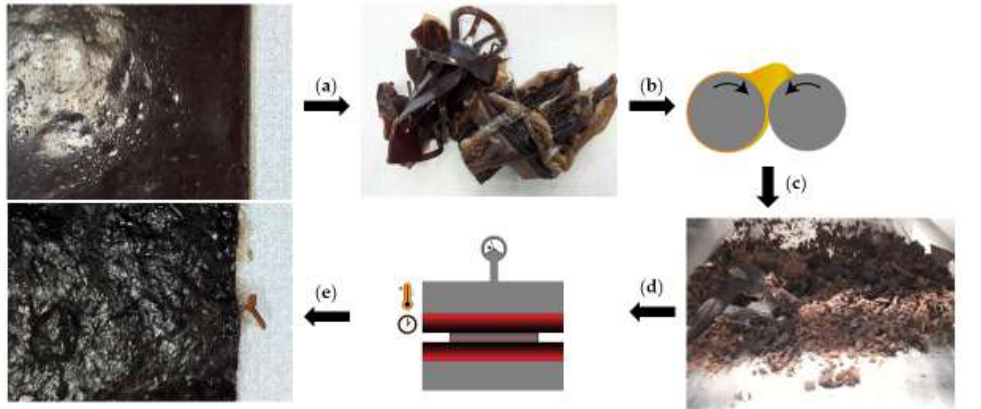
Figure 1. ( a ) Cured compound turned into waste; ( b ) transfer of waste to two roll mill for the mastication process; ( c ) coarse granulate after mastication; ( d ) transfer to manual hot press for recycling; ( e ) recycled compound.